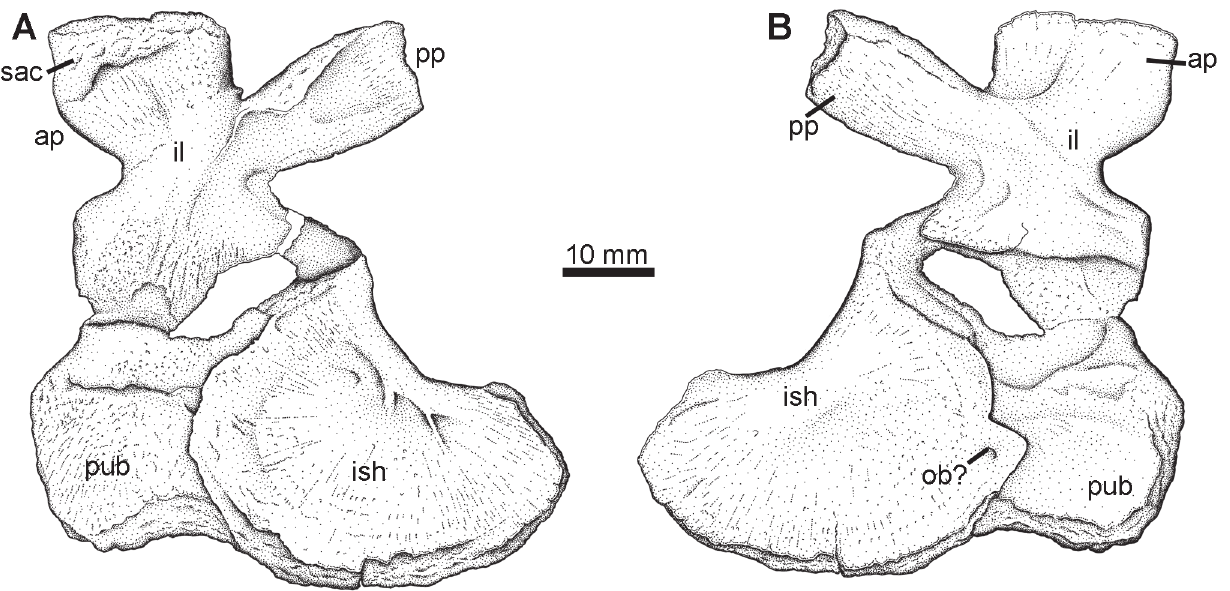
Fig 13. Pelvis Type 1. NSM005GF045.001, right pelvis in A, medial, and B, lateral views. Abbreviations : ap , anterior process; il , ilium; ish , ischium; ob , obturator foramen; pp , posterior process; pub , pubis; sac , sacral rib facet.